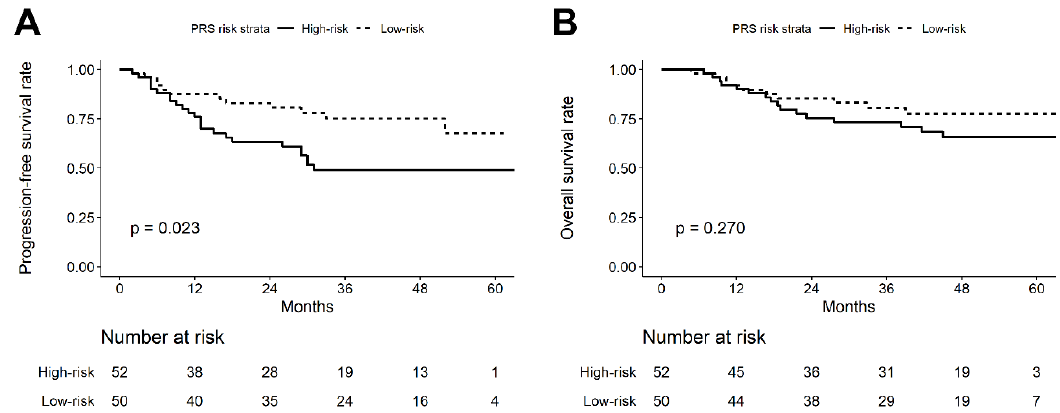
Figure 4. Kaplan–Meier plot of ( A ) progression-free survival (PFS) and ( B ) overall survival (OS) according to the PRS risk strata derived from the best multifactor protein combination.